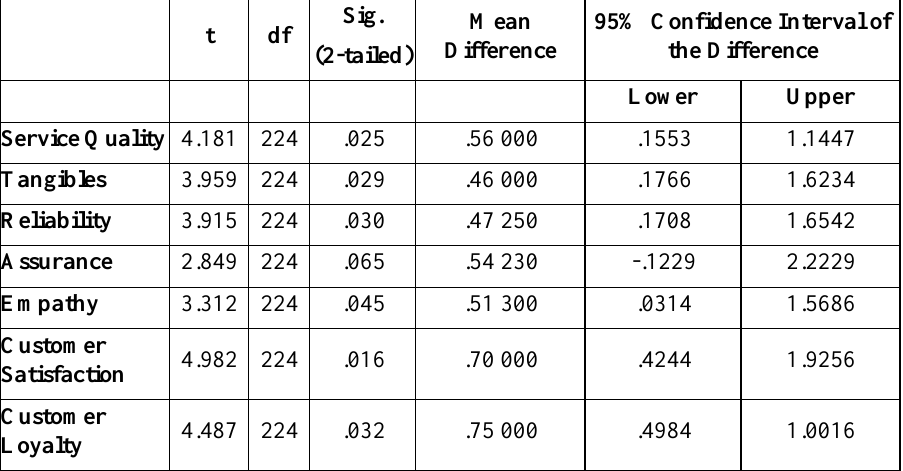
Table 3: One Sample